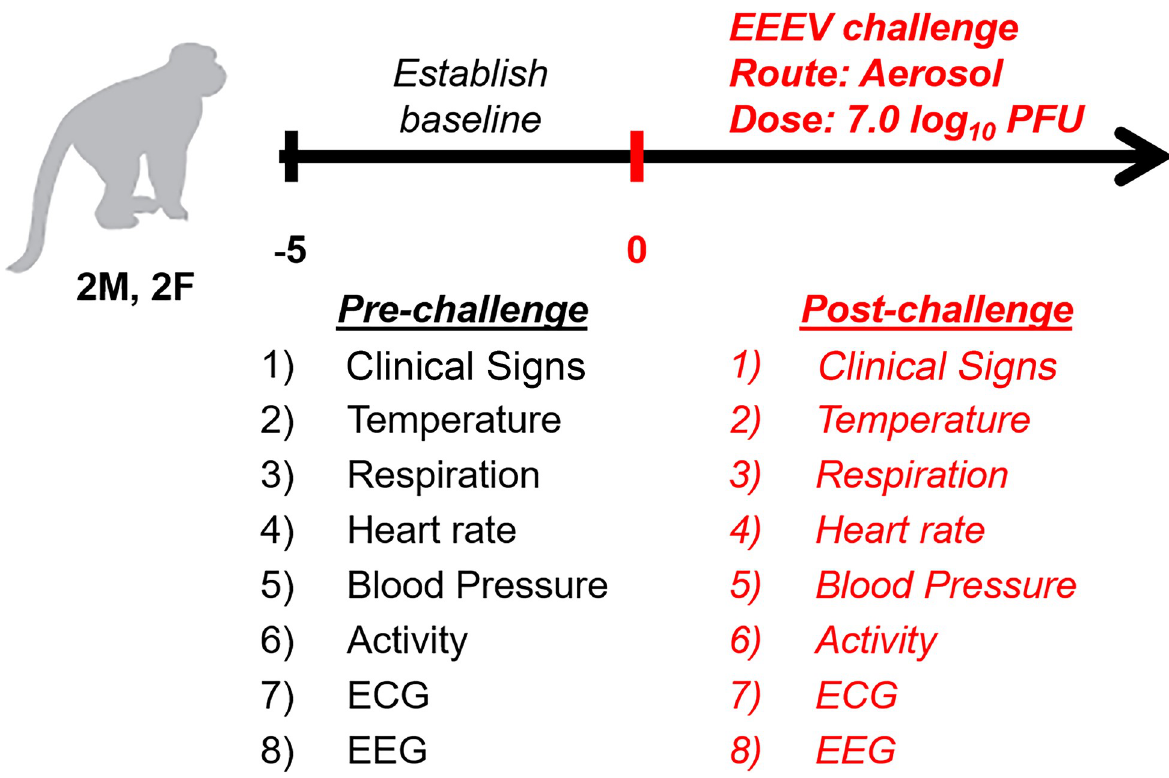
Fig 1. Experimental design of the NHP study. All parameters were continuously and simultaneously measured throughout the study. Baseline was established for each parameter for an individual NHP by measuring 5 daytime (6 am-6 pm) and nighttime (6 pm– 6 am). All comparisons of post- challenge data was time-matched to pre-challenge